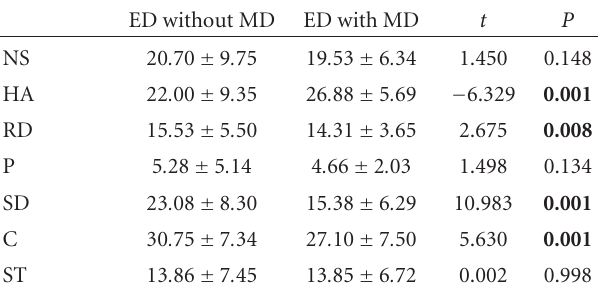
Table 5: Temperament and Character Inventory